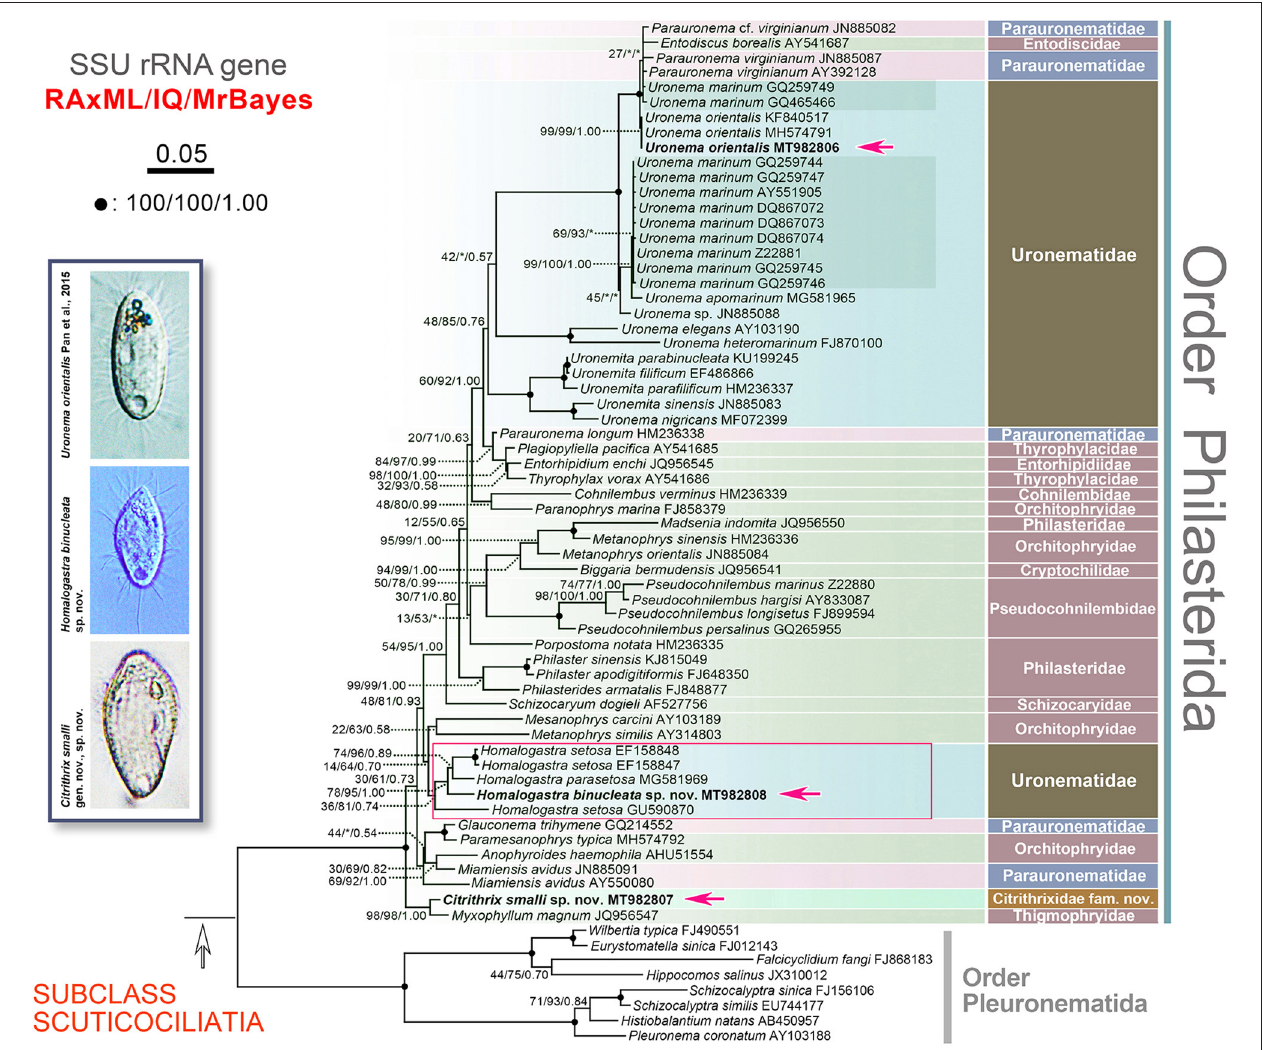
FIGURE 5 | RAxML tree inferred from SSU rRNA gene sequence data, red arrows point out the three newly sequenced populations. Numbers at nodes denote RAxML bootstrap values/IQTREE ultrafast bootstrap values/Bayesian inferences posterior probabilities. Asterisks (*) indicate mismatches of the topologies between RAxML, IQTREE and/or Bayesian inferences conducted in MrBayes. Fully supported (100%/100%/1.00) nodes are marked with black dots. The scale bar corresponds to five substitutions per 100 nucleotide positions. All branches are drawn to scale. The systematic classification mainly follows Lynn